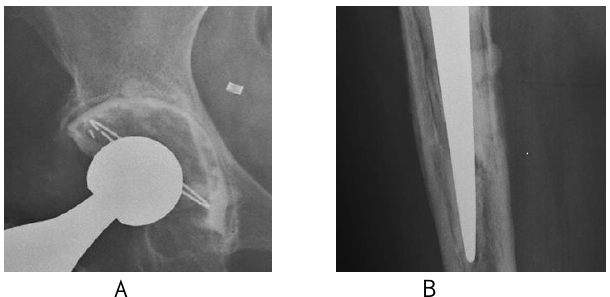
Figure 5 : Loosening of the cemented cup and stem А : Osteolysis of more than 2 mm width; В : breakage of the cement